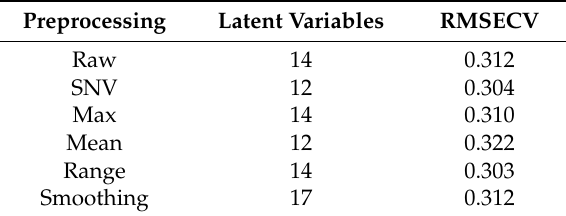
Table 1. Optimum number of latent variables and RMSECV explained by PLS-DA models with various preprocessing techniques.